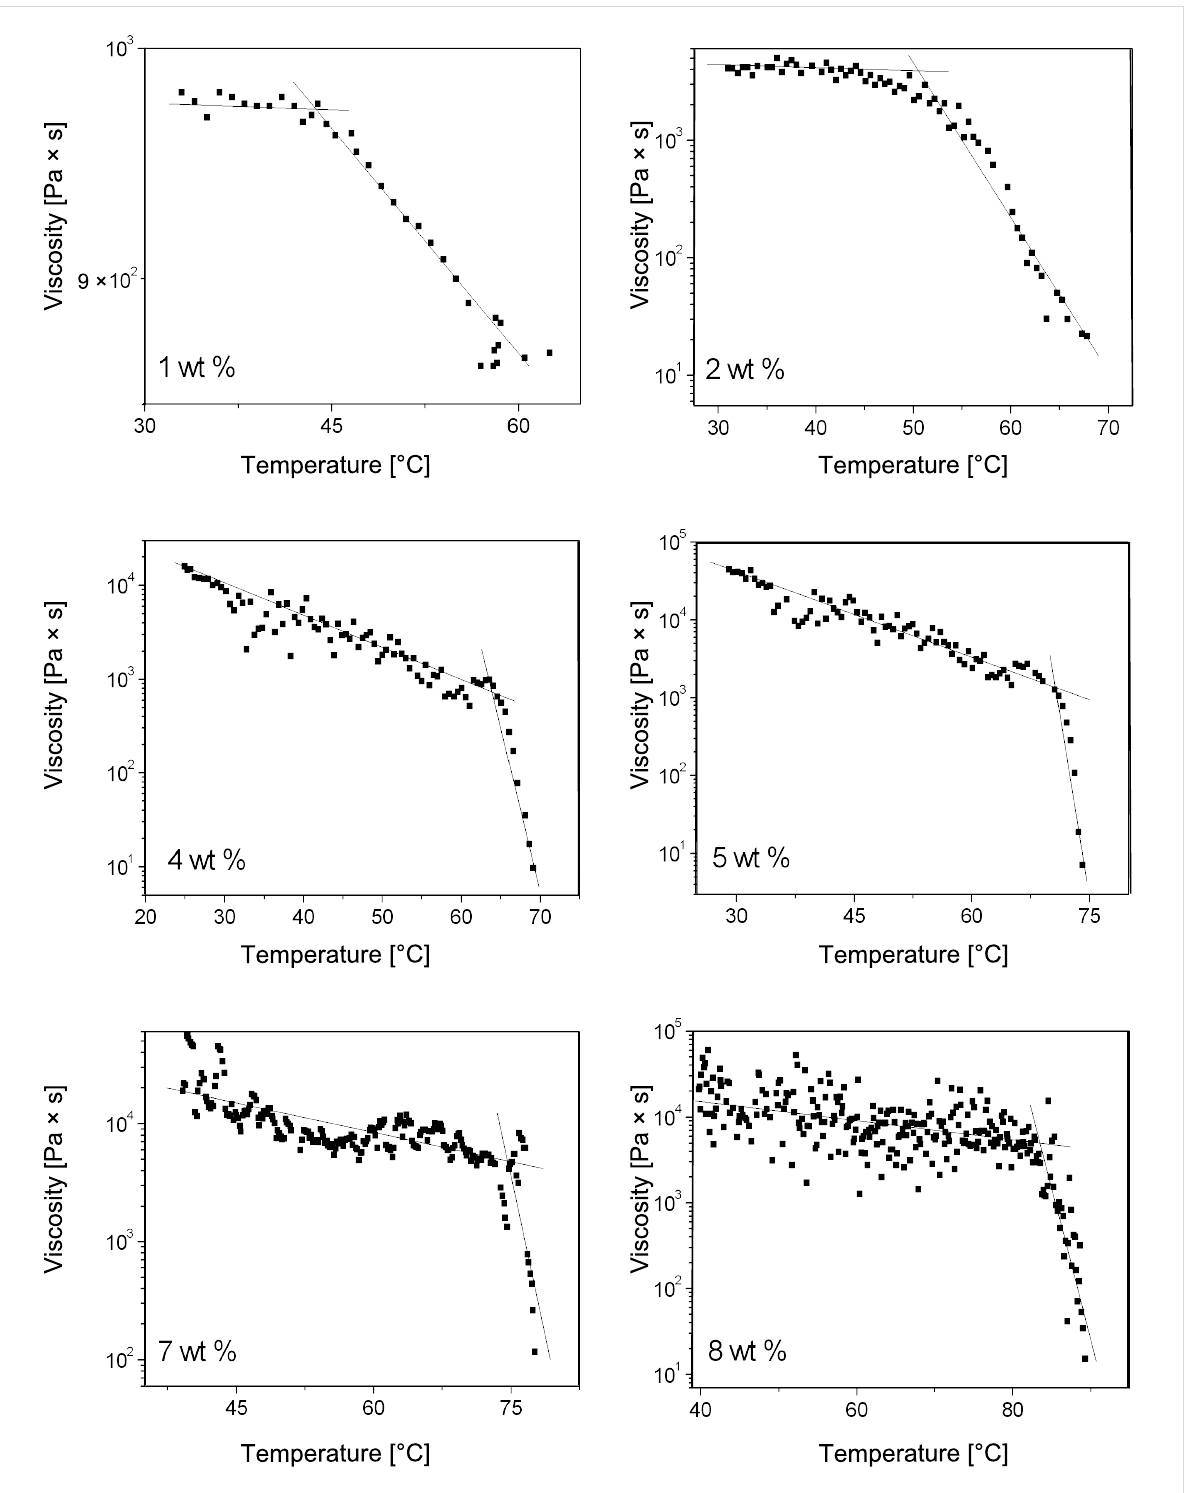
Figure 3: Dependence of viscosity of ODA-C /silicone oil gels on temperature at a shear stress of 1 Pa. From top left to bottom right: [ ODA ] = 1, 2, 4, 5, 7, and 8 wt %. Note that the viscosities of the 1 wt % sample have been plotted linearly and those at the other concentrations are plotted semi-loga-